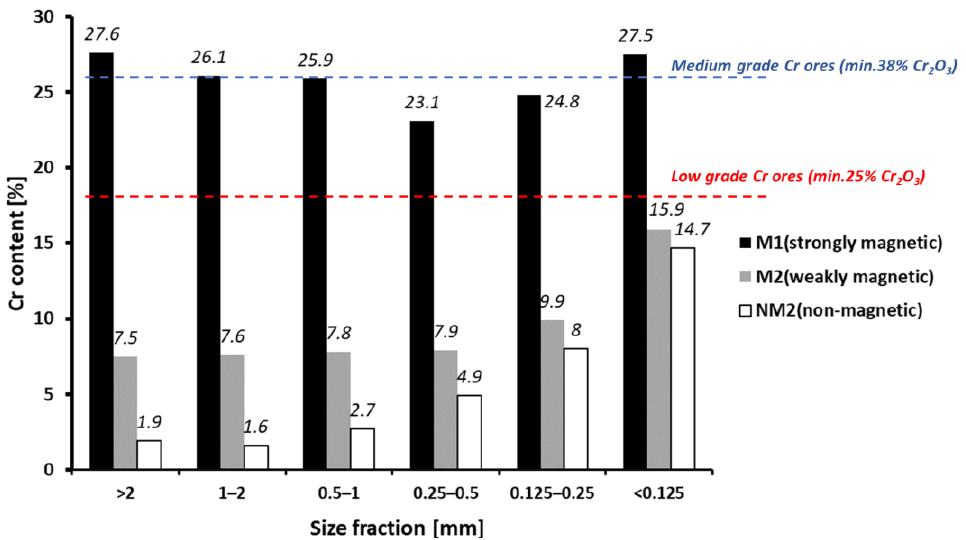
Figure 8. Cr content after magnetic separation of HC FeCr slag (Cr ores grades according to [13]).